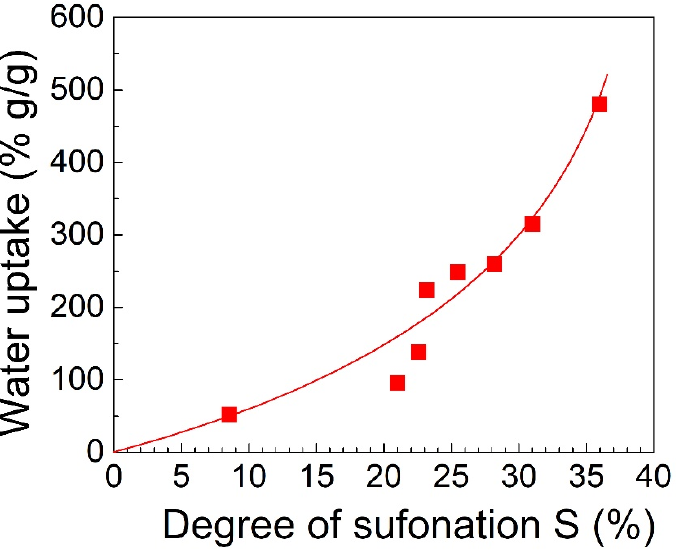
Figure 6. Water uptake at 25 °C of PPO monolithic aerogels with different degrees of sulfonation.